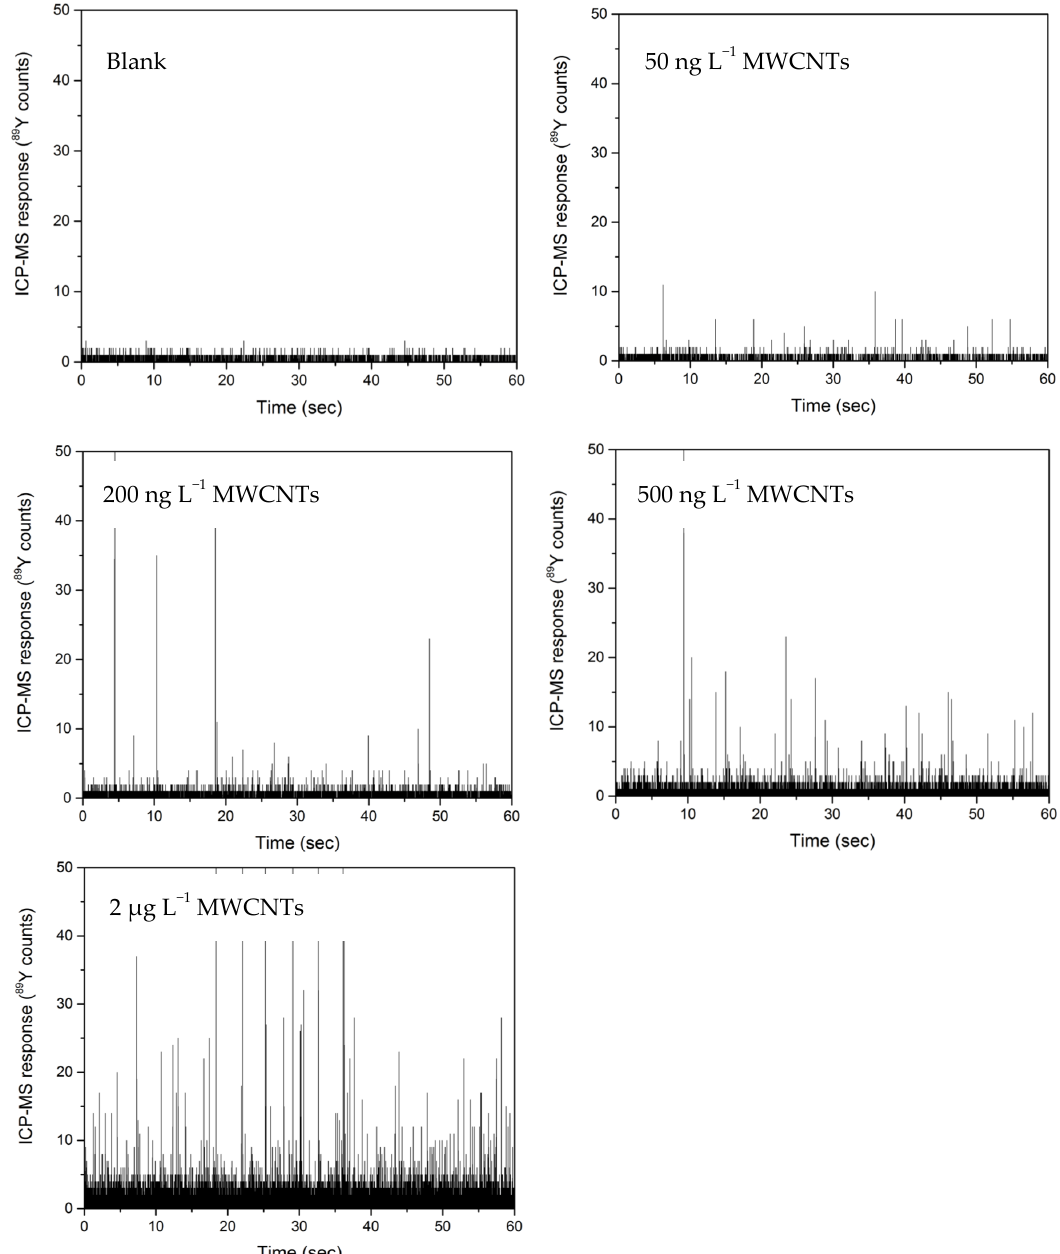
Figure 5. Single particle ICP-MS detection using 89 Y of MWCNTs in a solution across a range of concentrations plus a control (blank) sample.